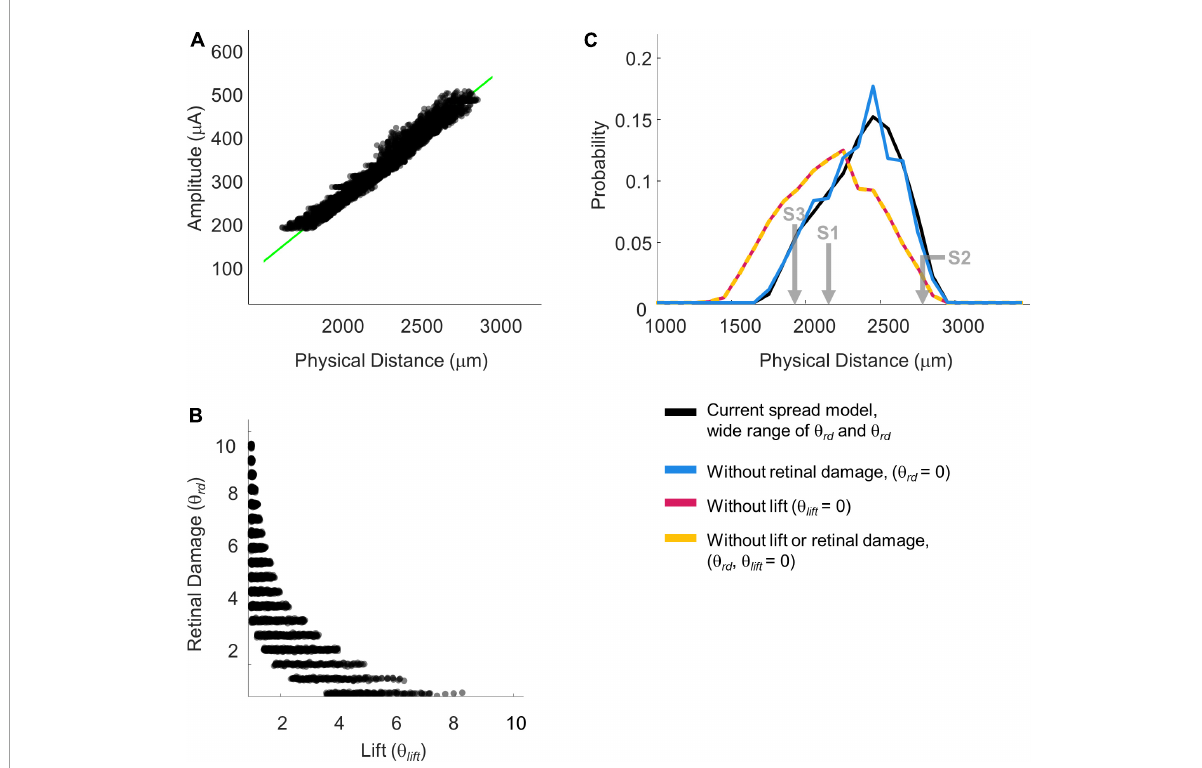
FIGURE10 Simulation parameterizations that match participant performance. (A) The green line representing 75% iso-performance without axonal stimulation is replotted from Figure 6 . Multiple overlapping black lines show simulated iso-dip contours sub-selected from parameterizations that matched the 75% two-point discrimination iso-performance curve. (B) Scatter plot of θ rd vs. θ lift for parameterizations which resulted in iso-dip contours [the black lines in panel (A) ] that closely resembled the predicted 75% iso-performance contour with minimal axonal stimulation [the green line in panel (A) ]. (C) Probability distributions of predicted two-point discrimination